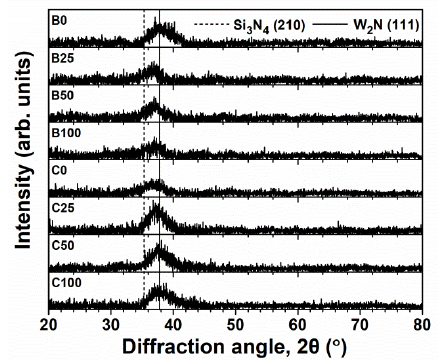
Figure 6. Grazing incident X-ray diffraction (GIXRD) patterns of W–Si–N films.